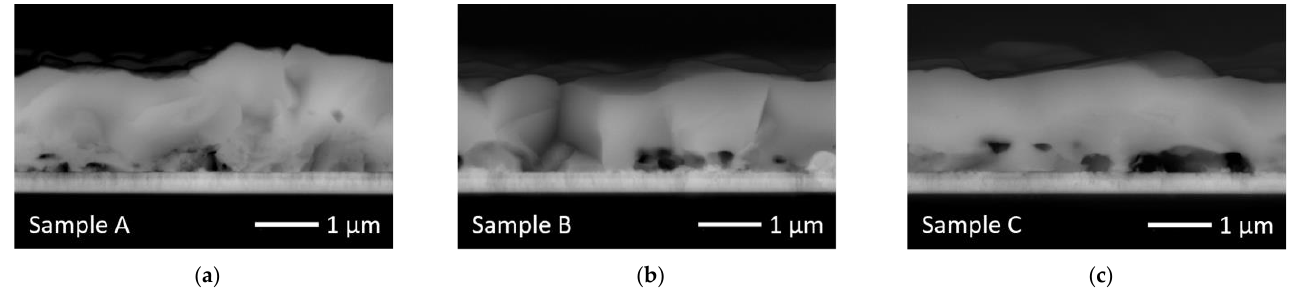
Figure 4. Typical appearance of absorber cross sections: ( a ) sample A; ( b ) sample B; ( c ) sample C.